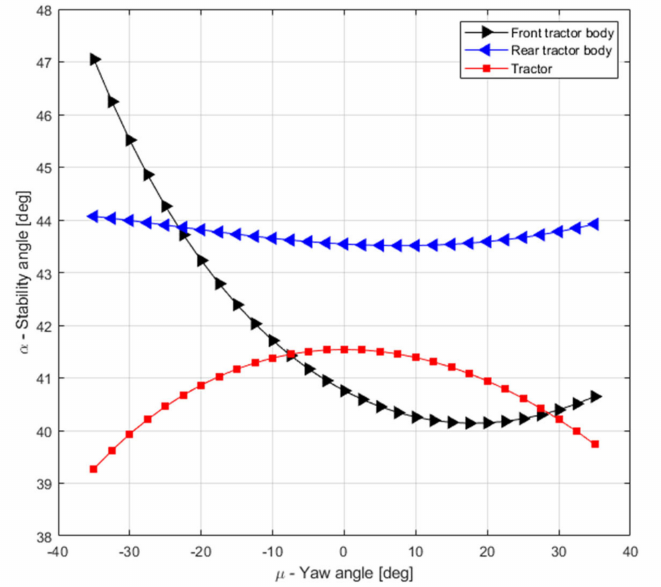
Figure 9. Tractor in the articulated configuration: tractor stability angles vs. Yaw angle. Front tractor body (black line), rear tractor body (blue line) and whole tractor (red